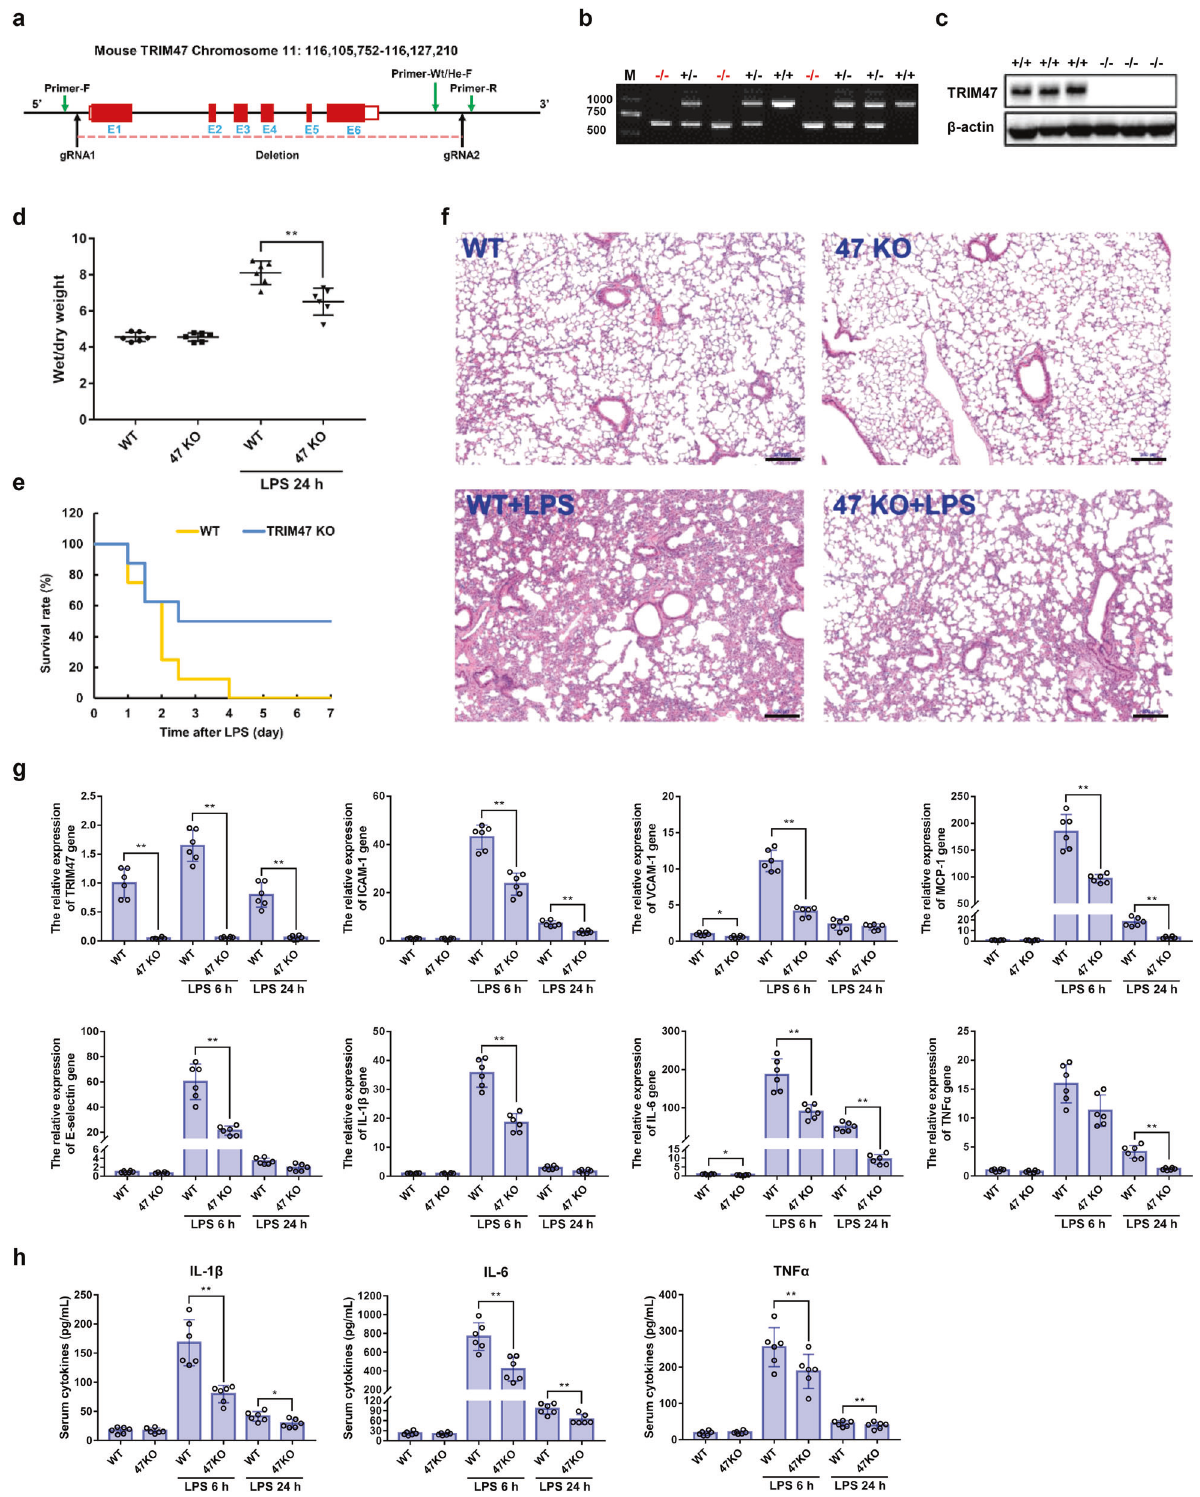
Fig. 3 TRIM47 de fi ciency reduces LPS-induced acute lung injury and pulmonary in fl ammation in mice. a Schematic strategy of generation of TRIM47 knockout mice. b Representative images of agarose gel electrophoresis for genotyping of TRIM47 + / + , TRIM47 + / − , and TRIM47 − / − mice. c Representative images of the immunoblots of TIRM47 and β -actin in lungs from TRIM47 + / + and TRIM47 − / − mice detected by western blot. d Pulmonary edema was represented as lung wet-to-dry ratio ( n = 6, one-way ANOVA, ** P < 0.01). e Survival rate of mice intraperitoneally administered with 15 mg/kg LPS ( n = 16, the log-rank test, P < 0.01). f Representative images of the histological changes in lungs after LPS challenge examined by HE staining ( n = 6). Scale bar, 100 μ m. g The relative expression of TRIM47 and various pro-in fl ammatory cytokines in lungs was measured by real-time PCR ( n = 6, one-way ANOVA, * P < 0.05, ** P < 0.01). h The content of IL-1 β , IL-6, and TNF α in the serum was detected by ELISA ( n = 6, one-way ANOVA, * P < 0.05, ** P < 0.01)